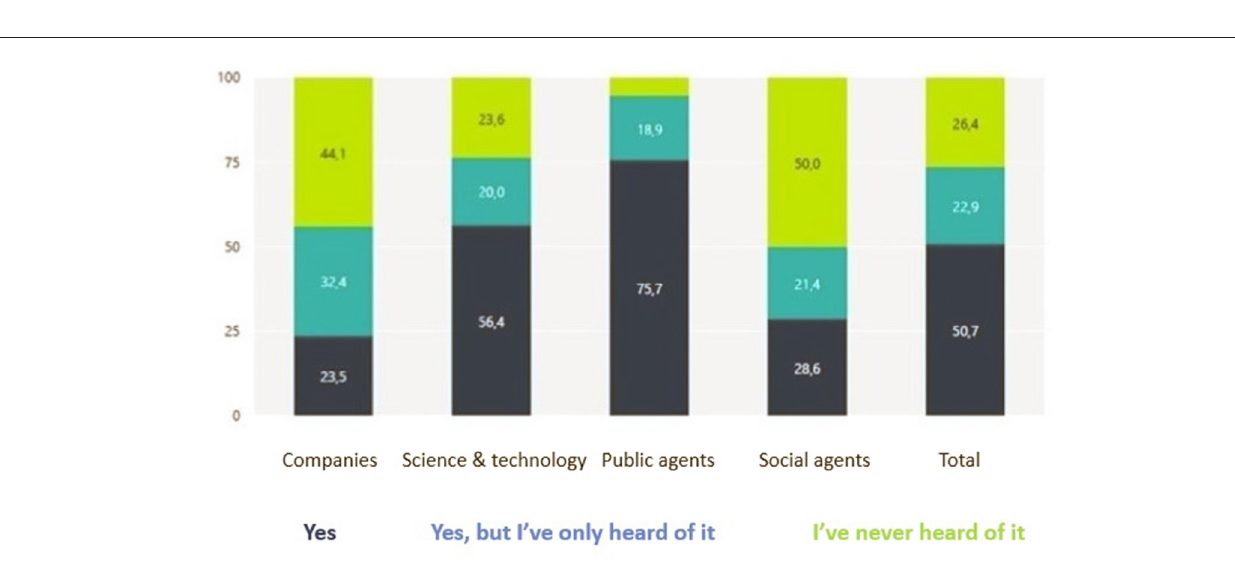
FIGURE 2 | Extent of knowledge of RIS3 in the Valencia region (Spanish autonomous community), 2020. Source: “Analysis of the Valencian economy and the Valencian innovation system. Diagnosis in the current context” (Reig et al., 2020).